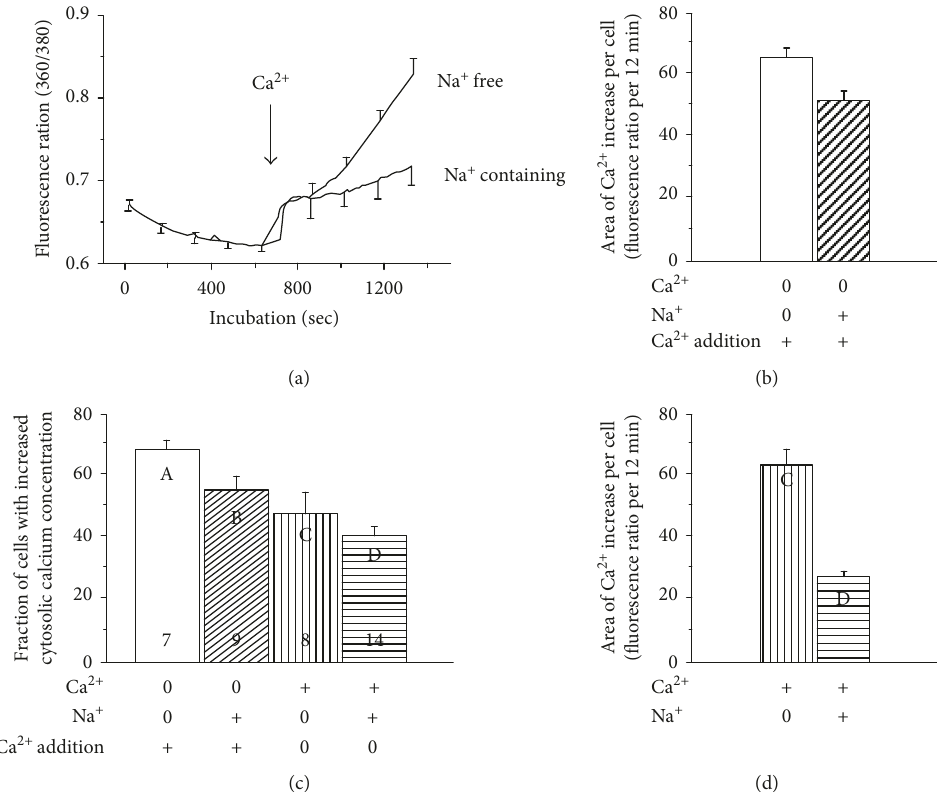
Figure 4: Calcium-induced increase of cytosolic Ca 2+ in di ff erentiating cells incubated in the absence or presence of Na + . After dye loading in the presence of Ca 2+ , cytosolic Ca 2+ was monitored in cells incubated in a calcium-free medium with or without Na + and then 2mM Ca 2+ was added (arrow) (a). The area under the curve (AUC) of the e ff ect of Ca 2+ addition is shown (b). The fraction of cells that respond to the addition of 2mM Ca 2+ with increased cytosolic Ca 2+ is shown (c). The cells were incubated in the absence and presence of Na + and then exposed to 2mM Ca 2+ ((c), columns A, B). Columns C and D show the fraction of cells with spontaneous Ca 2+ increase in the absence and presence of Na + . AUC of the spontaneous Ca 2+ increase is shown in columns C and D in Figure 4(d). GraphPad Prism4 was used to calculate AUC, expressed as fl uorescence intensity (excitation ratio 360nm/380nm) per cell per 12 min (b) and 20 min (d), respectively. Mean value and SEM from 7 and 9 independent experiments (Figure 4(a)). Mean values and SEM from 296 cells and 270 cells incubated in the absence or presence of sodium, respectively (Figure 4(b)). Mean values and SEM from 7 – 14 experiments (Figure 4(c)) and 226 cells and 384 cells in Figure 4(d) (columns C and D, resp.). Column D in Figure 4(c) represents the data shown in Figure